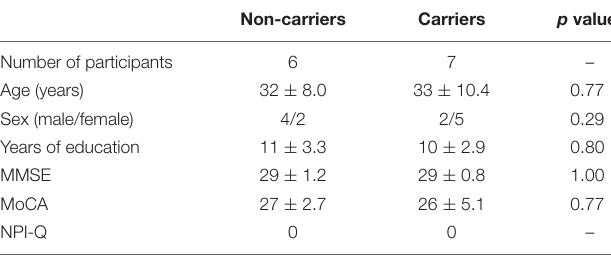
TABLE 1 | Demographic data of mutation non-carriers and carriers at baseline.